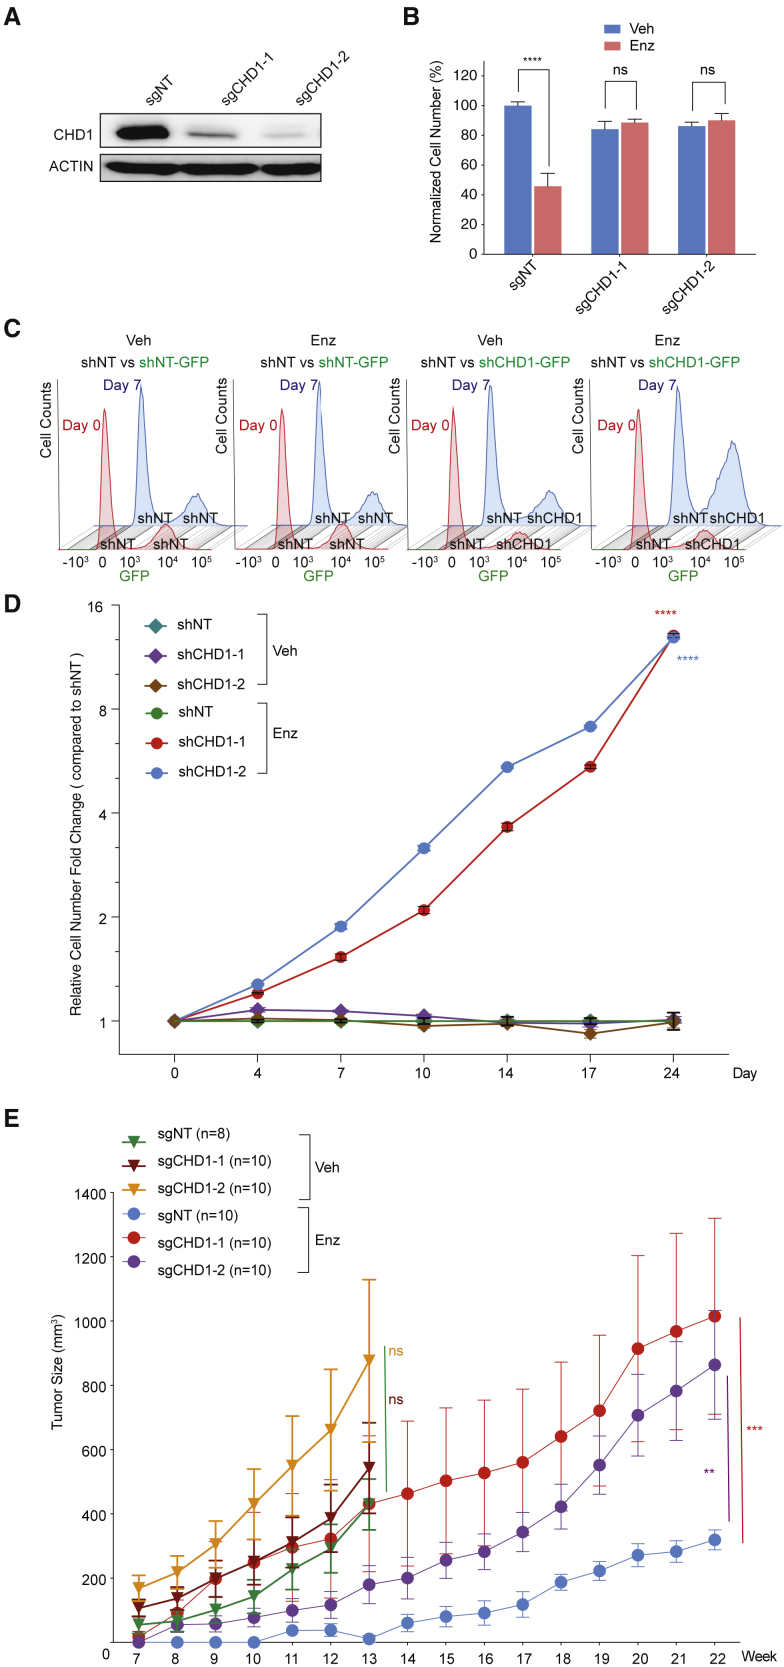
CHD1 Loss Confers Significant Resistance to Antiandrogen In Vitro and In Vivo(A) Western blot of CHD1 in LNCaP/AR cells transduced with annotated guide RNAs.(B) Relative cell number of LNCaP/AR cells transduced with annotated guide RNAs, normalized to sgNT + Veh group. Cells were treated with 10 μM enzalutamide (Enz) or DMSO (Veh) for 7 days and cell numbers were counted. p values were calculated using multiple t tests, three biological replicates in each group.(C) Histograms of representative fluorescence-activated cell sorting-based competition assay showing the distribution of shNT LNCaP/AR cells (GFP-negative) compared with cells transduced with cis-linked shCHD1-GFP or shNT-GFP shRNAs (GFP positive). The distribution on day 0 is shown in red and day 7 is shown in blue.(D) Relative cell number fold change compared with shNT group, based on the results of (C). Enz denotes enzalutamide of 10 μM and Veh denotes DMSO. p values were calculated using two-way ANOVA, three biological replicates in each group.(E) Tumor growth curve of xenografted LNCaP/AR cells transduced with annotated guide RNAs. Enz denotes enzalutamide treatment at 10 mg/kg from day 1 of grafting. Veh denotes 0.5% CMC + 0.1% Tween 80.p values were calculated using two-way ANOVA. For all panels, mean ± SEM is presented. ∗∗∗∗p < 0.0001, ∗∗∗p < 0.001, ∗∗p < 0.01, ∗p < 0.05. See also Figures S2 and S3.